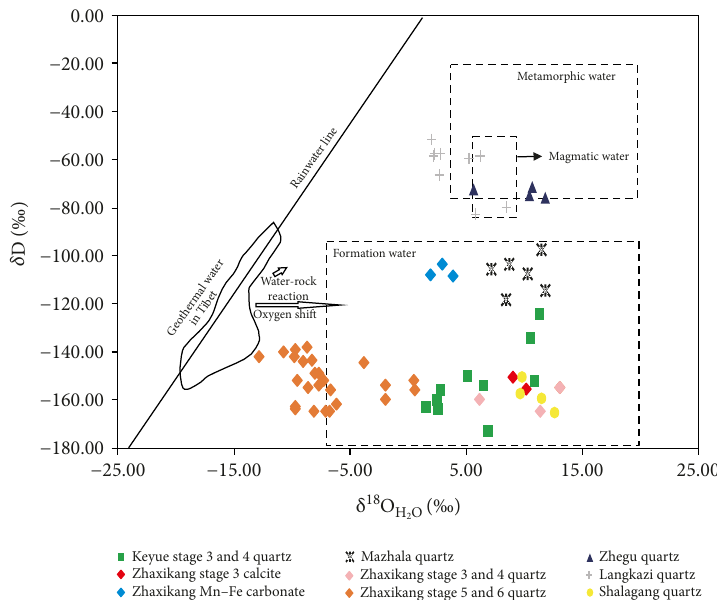
Figure 15: Diagram of δ D versus δ 18 O for quartz from the Keyue Sb – Pb – Zn – Ag deposit, compared with Zhaxikang (data cited from H2O Yang et al. [3], Meng et al. [6], Xie et al. [17], Li [76], and Zhang [77]), Shalagang, Mazhala, Zhegu, and Langkazi deposits (data cited from Yang et al. [3]) in